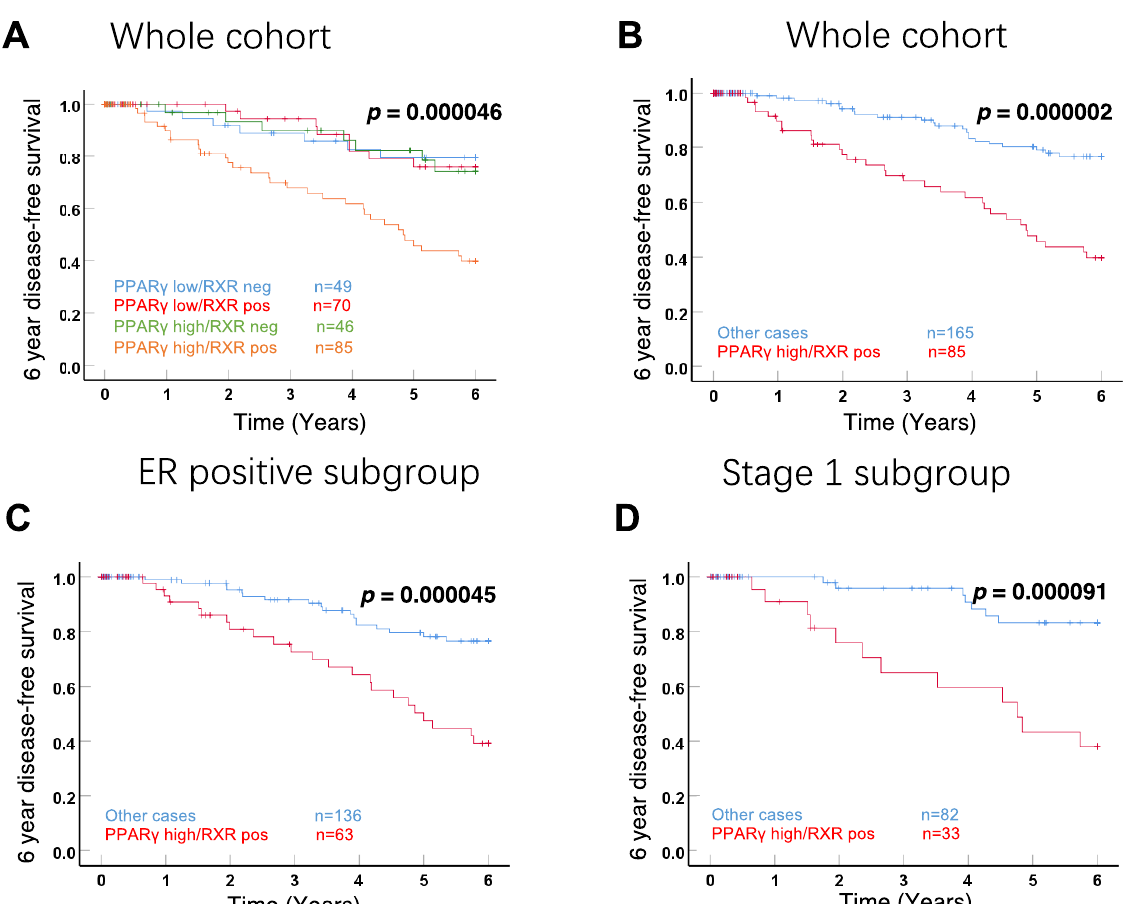
Figure 3. Kaplan–Meier analyses of 6-year disease-free survival for the 4 subgroups with different RXRα and PPARγ expression ( A ), positive RXRα/ high expression PPARγ compared to all other cases ( B ) and ER-positive ( C ) or stage 1A ( D ) BCs.